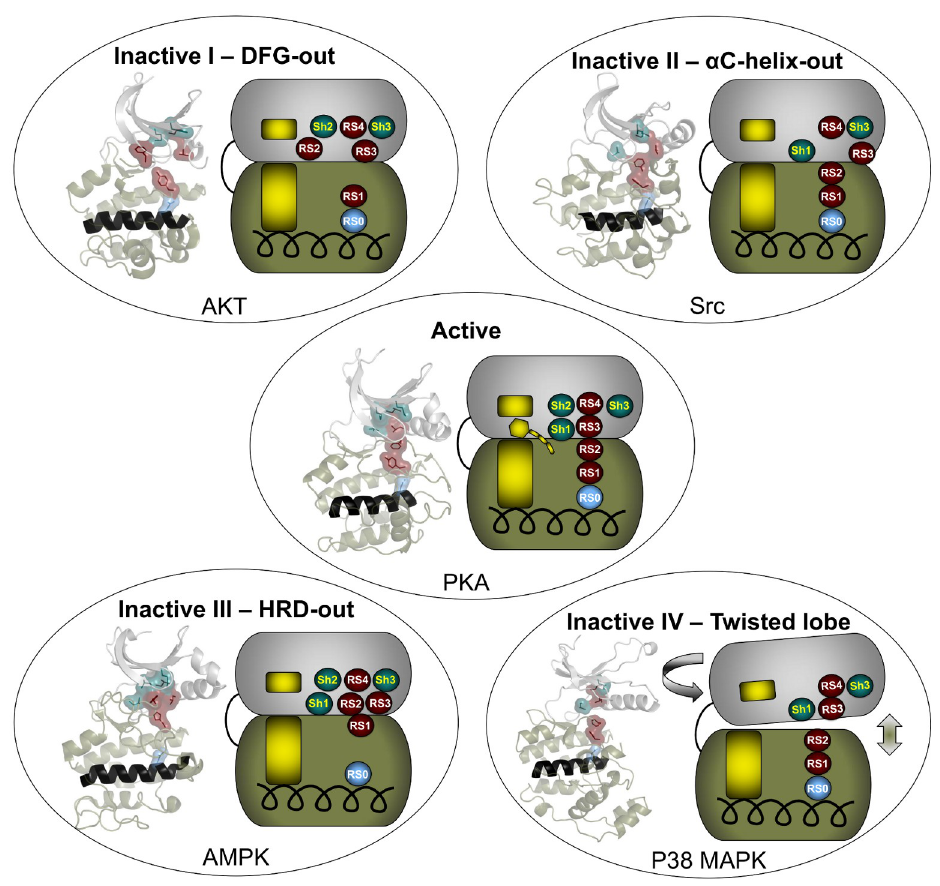
Fig 7. A figure from Meharena et al. showing the R-spine configuration in the active state (center) and four different inactive conformations. Cartoon depictions of representative kinase structures are shown alongside schematic representations of the N- and C-lobes, with the C-spine depicted in gold, R-spine residues depicted in burgundy, and Shell residues in teal. Image reproduced under CC-BY 4.0 license, credit: